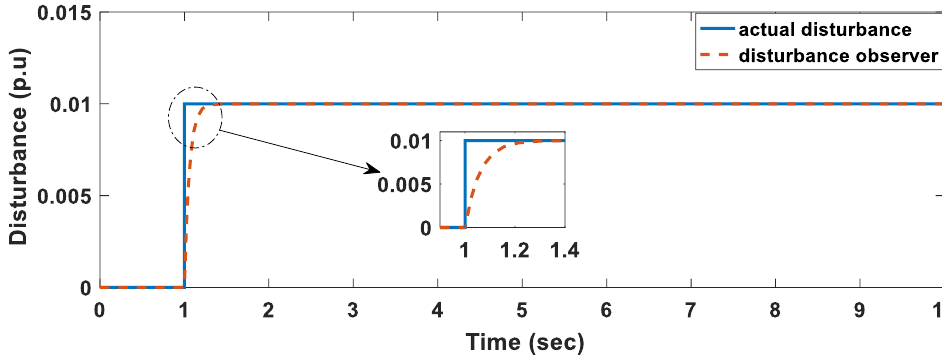
Figure 5. Estimated and actual disturbance for scenario 1.